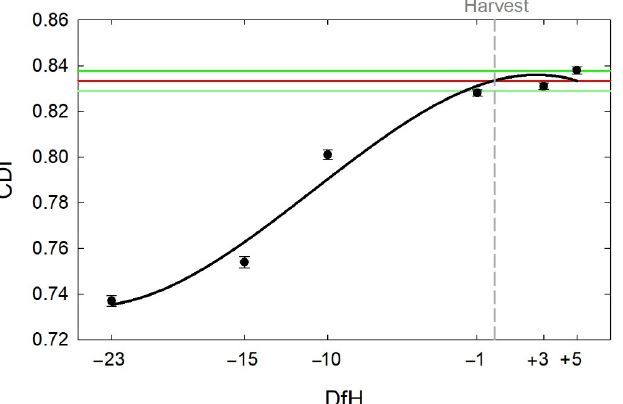
Figure 10. Cubic regression fit (black line) of Colour Development Index (CDI) against time (days from harvest, DfH) in ‘Majestic Pearl’ nectarine fruit measured in 2021–2022. The points represent means of experimental units (row orientation arm; n = 4) at different times form harvest and vertical bars show standard errors of the means. The red horizontal line represents the predicted CDI value at harvest (DfH = 0) and green lines represent the standard errors of the prediction. Model equation: CDI = 0.833 + 0.002 × DfH − 0.0003 × DfH 2 − 1.04 × 10 − 5 × DfH 3 ; p < 0.001; R 2 = 0.973; S.E. = 0.011.